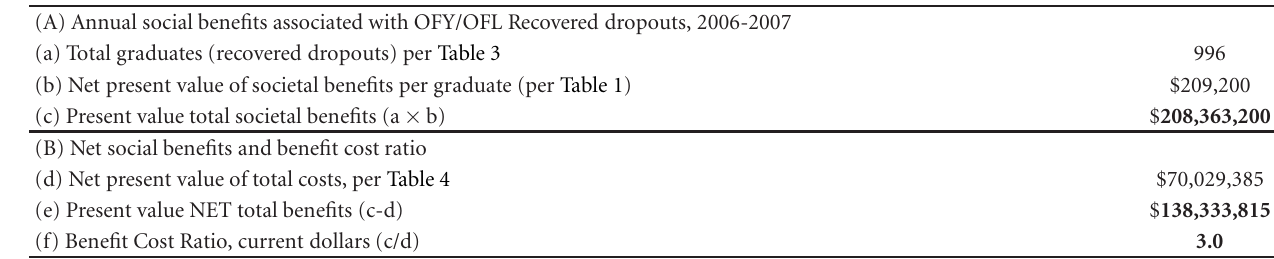
Table 5: Ratio of benefits to costs of OFY/OFL dropout